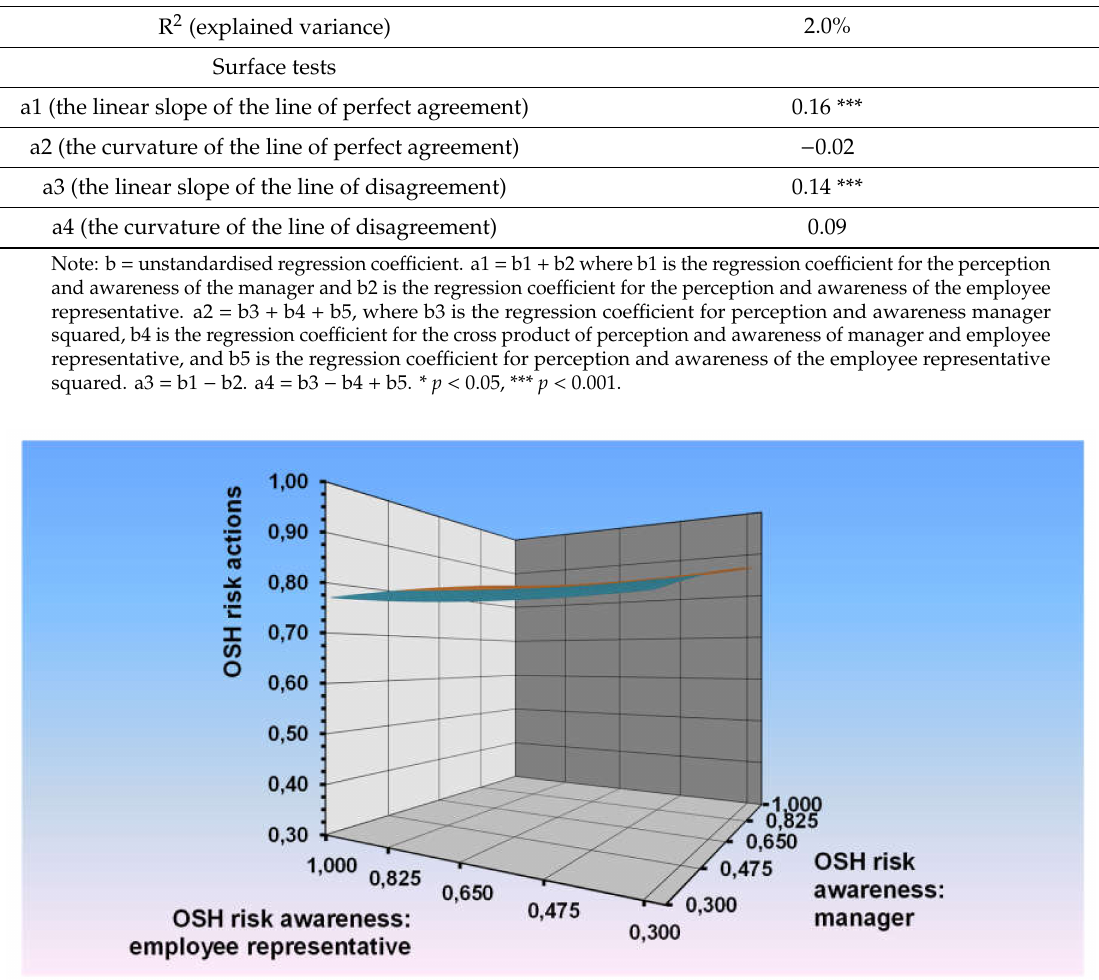
Figure 2. OSH risk actions explained by the combination of the OSH risk perception and awareness of the manager and the employee